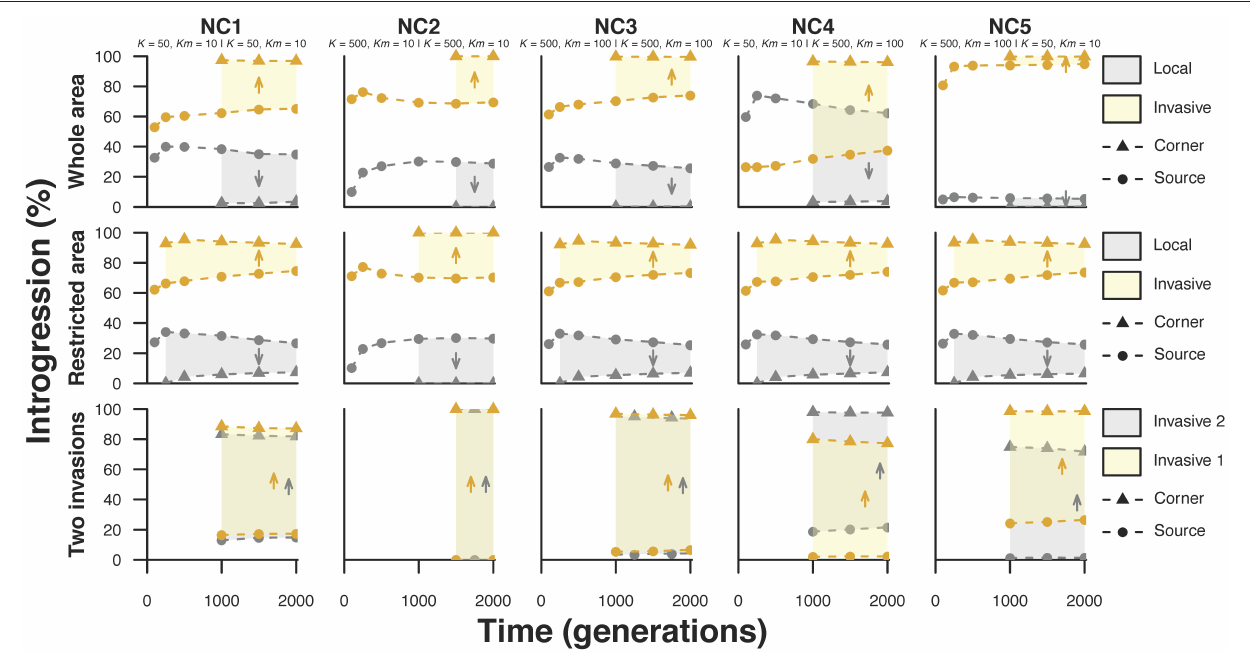
FIGURE 4 | Effect of time since the onset of biological invasion on the level of introgression. Two interacting taxa are represented with different colors (yellow and gray). The level of introgression (%) is estimated in both the source of the expansion and the extreme corner in which both taxa are present. The arrows indicate